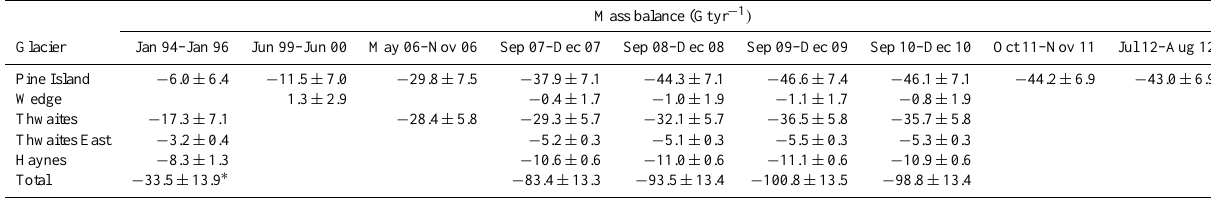
Table 5. Mass balance measurements and errors from 1994 to 2012.